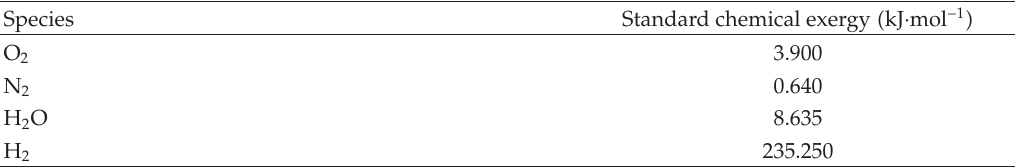
Table 2: Standard chemical exergies (cid:5) 30 (cid:6)